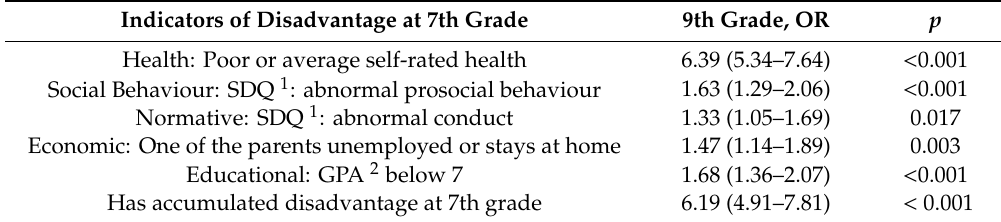
Table 3. Odds ratios (OR, 95% CI: Confidence Interval) for each indicator of disadvantage at the 9th grade when having the same disadvantage at the 7th grade. ( N = 4239–5677). Indicators of Disadvantage at 7th